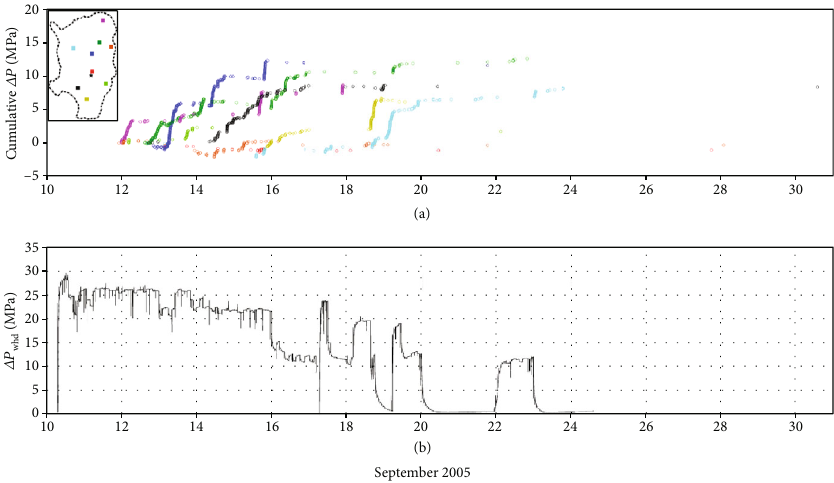
Figure 13: (a) Temporal evolution of cumulative fl uid pressure changes determined from overlapping slips at the 9 locations in the reservoir indicated by corresponding colours in the small fi gure inset. A constant stress drop of 0.1MPa is assumed. Contour line in the fi gure inset denotes the main region of seismic activity after projection and rotation operations. The black star denotes fault intersection of the well Habanero#1. (b) Temporal evolution of the pressure changes Δ P whd measured at the wellhead of Habanero#1 during the restimulation in September 2005. Pressure changes were determined by subtracting the initial overpressure of 33 MPa from pressure readings.